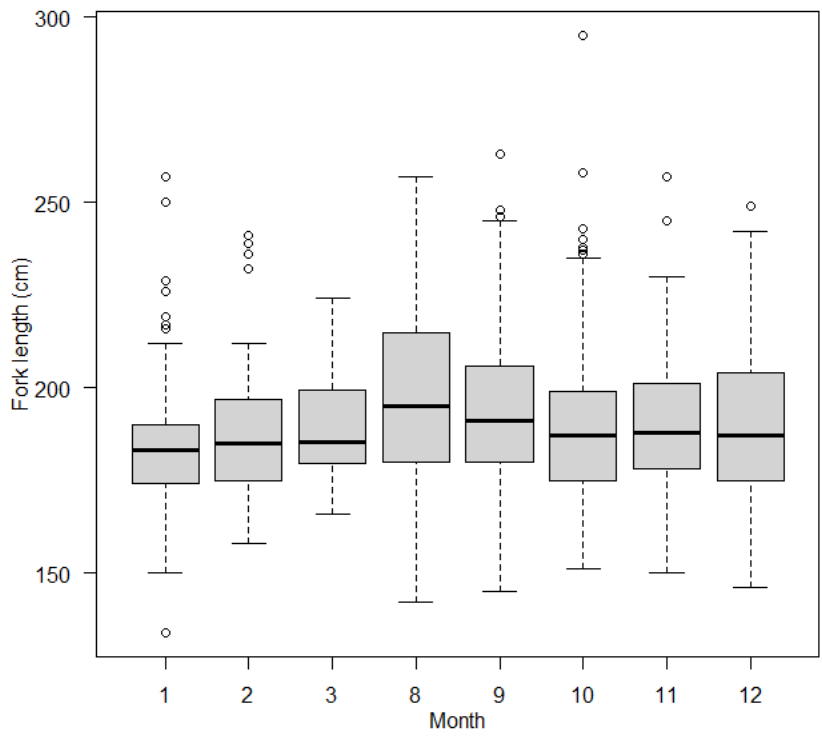
Figure 9. Observed fork length by month in the Pacific Ocean.